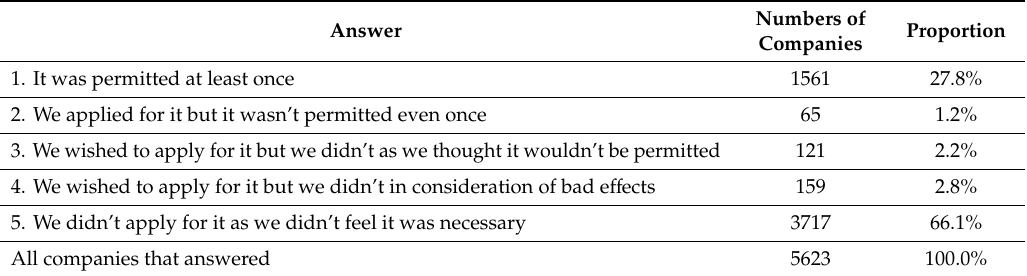
Table 2. Changes in loan repayment conditions since the Financing Facilitation Act was